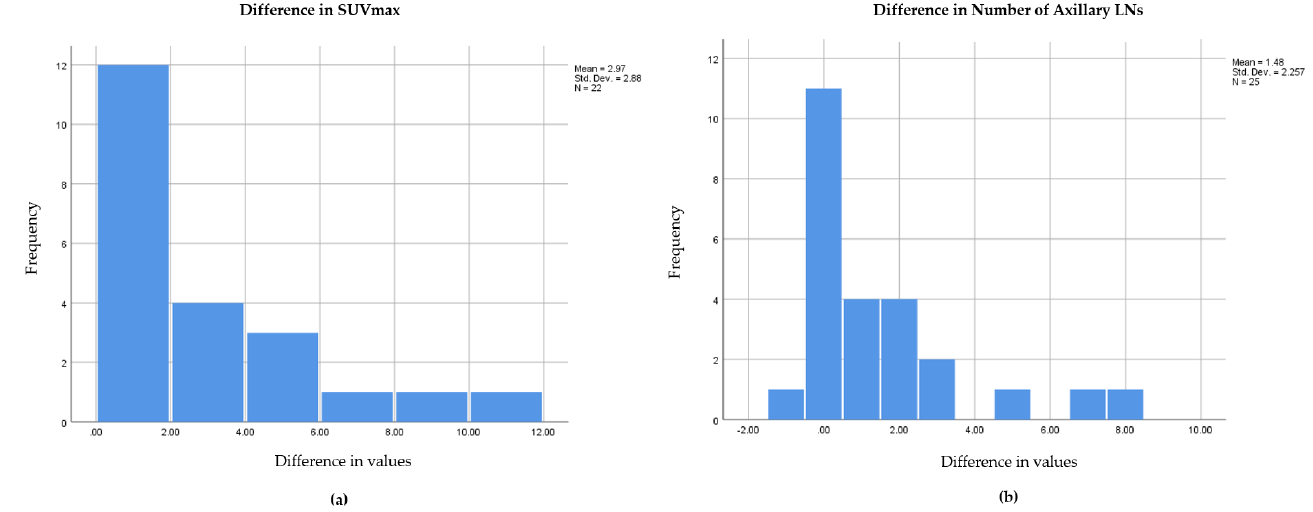
Figure 1. Histograms of difference in SUVmax ( a ) and difference in number of axillary LNs ( b ) showing skewed